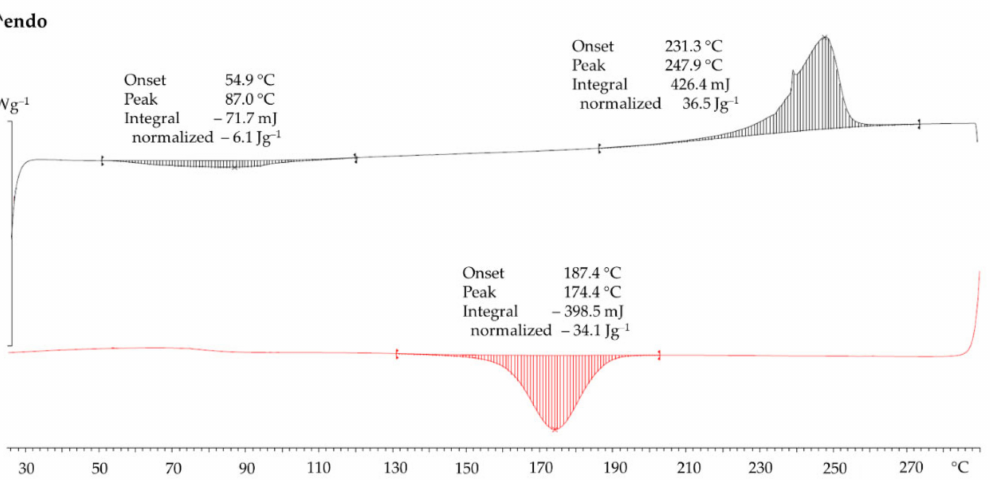
Figure 10. DSC curve of a PET bar manufactured by HSS. The heat of fusion is 36.5 J/g, melting onset is at 231.3 ◦ C, and peak is at 247.9 ◦ C. Note the weak exothermic event with onset at 54.9 ◦ C and peak at 87.0 ◦